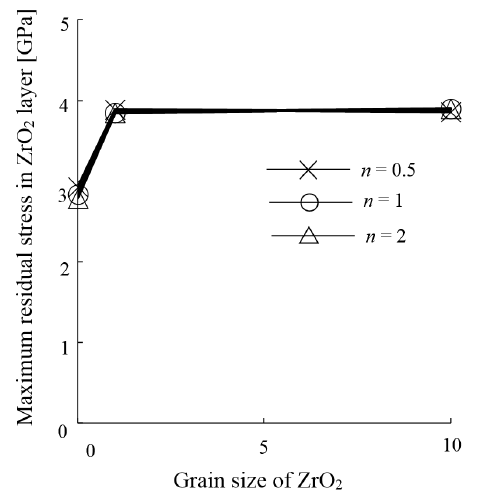
Figure 5. Residual stress states in the ZrO 2 surface layer just after fabrication processes for functionally graded materials (FGMs) with n = 0.5, 1 and 2.